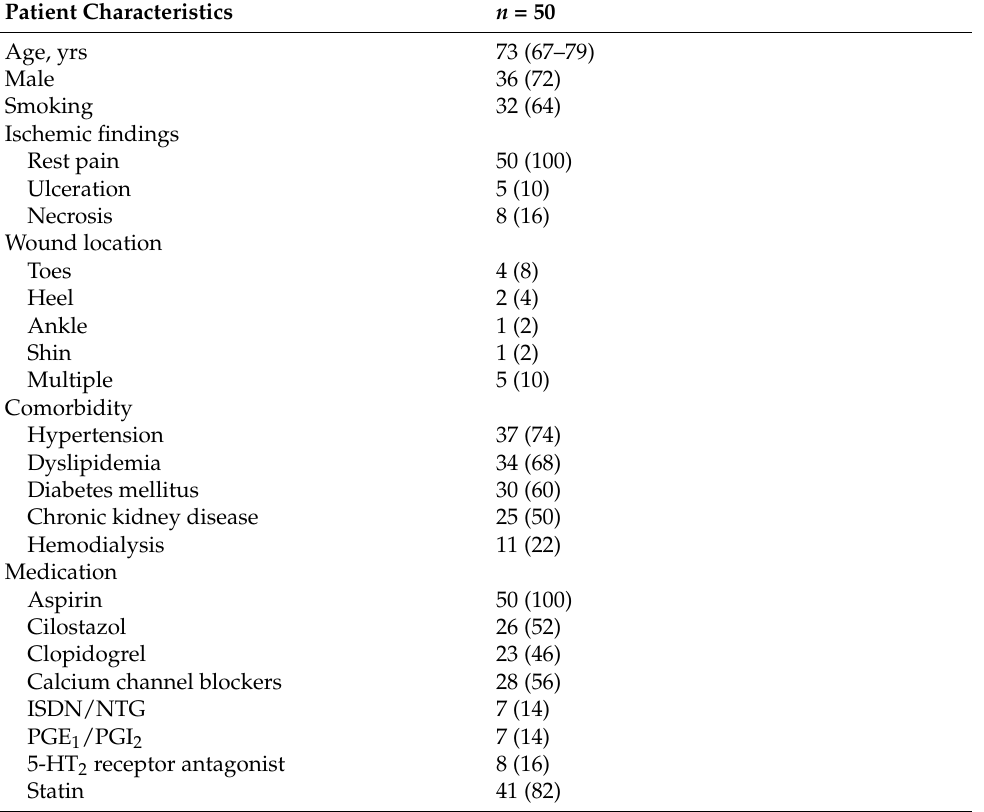
Table 1. Patient characteristics in the critical limb ischemia (CLI)